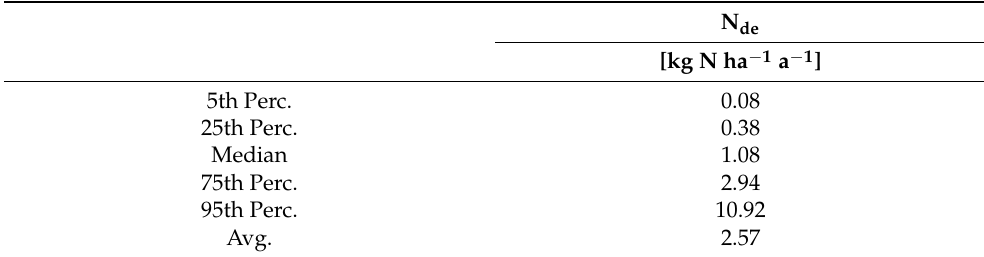
Table 13. Statistical distribution of the determined denitrification rates (N de ) for the receptor areas in the German critical load